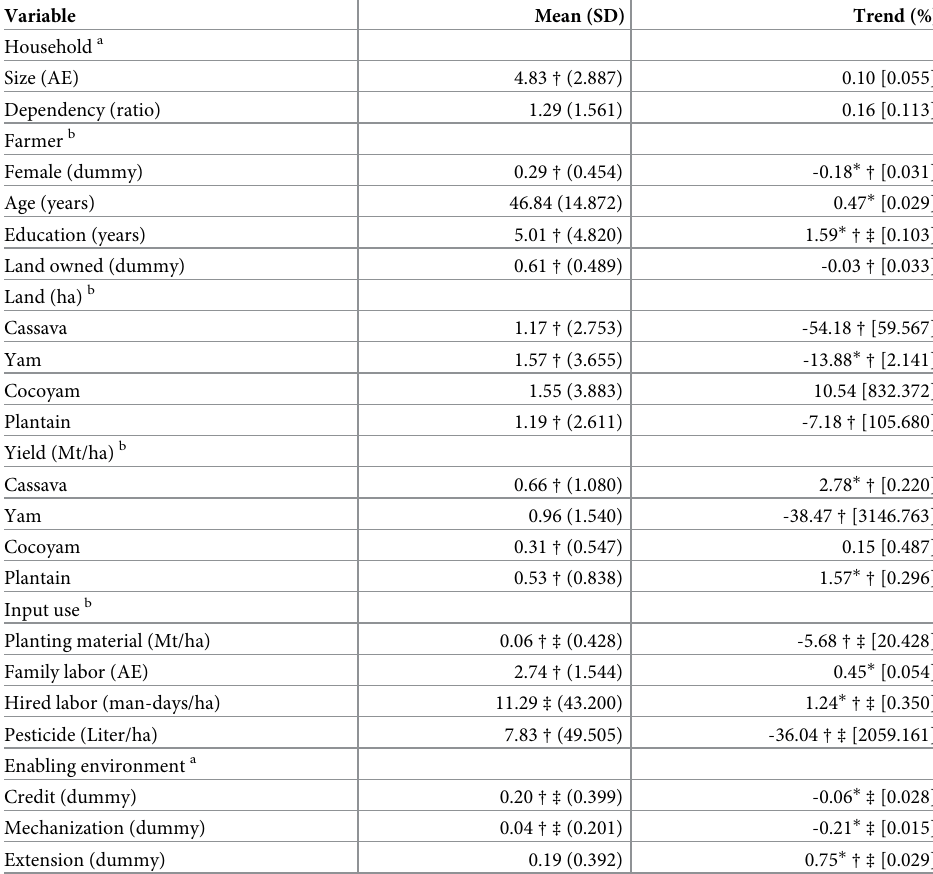
Table 1. Summary statistics of starchy staple producing farmers in Ghana